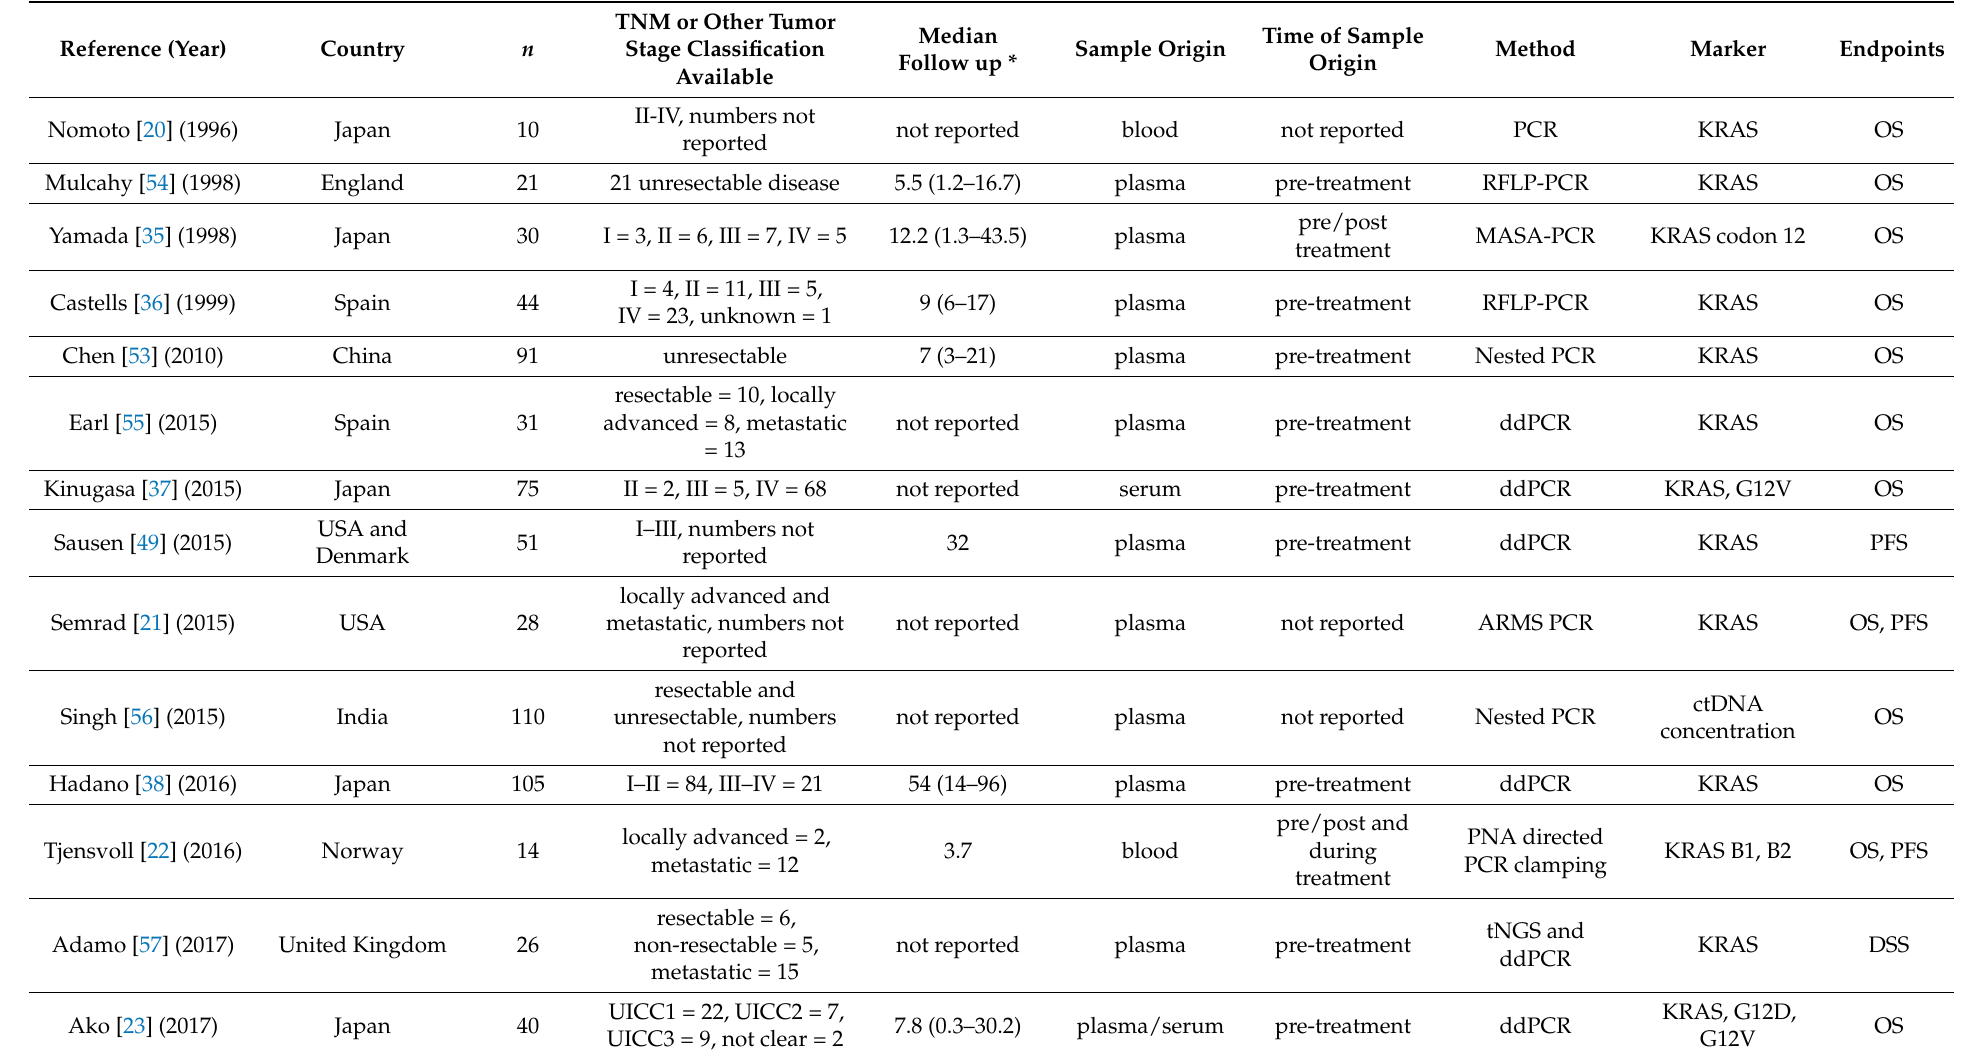
Table 1. Overview of the current literature on circulating tumor DNA in pancreatic cancer, with survival endpoints and patient group